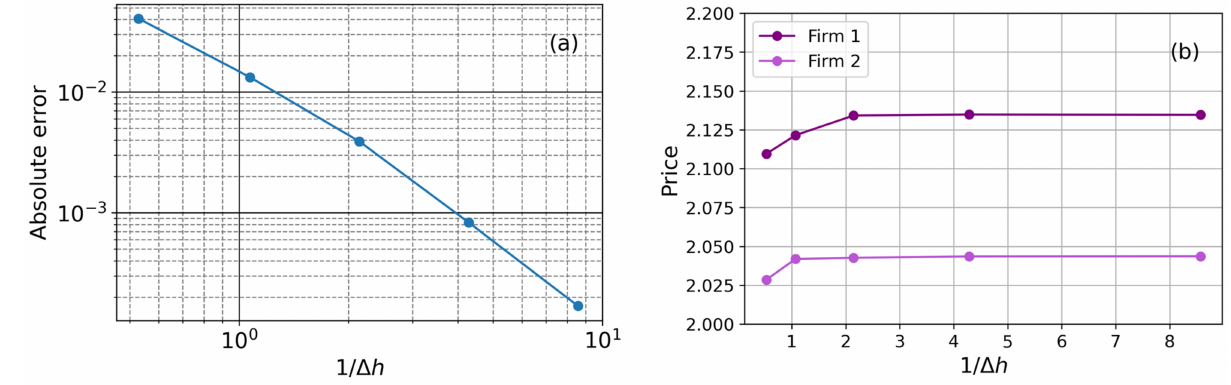
Figure 2. Convergence with mesh size. ( a ) Absolute error of price vector; ( b ) prices of two firms. The comparison of the convergence rate between a Barzilai–Borwein adaptive step and a constant step, as well as the convergence rate of the iterative method by using different meshes, is shown in Figure 3. The rate of convergence of the Barzilai–Borwein method significantly exceeds the usage of a constant step. One can see that the usage of a larger constant step with a coarse mesh forces the iterative algorithm to oscillate around the solution (Figure 3a), η = 1 or η = 0.5. These oscillations result from the non-smooth demand function, which leads to jumps in the computation of its derivative with respect to price. The smoothness of the demand function was improved by refining the mesh (Figure 3b).